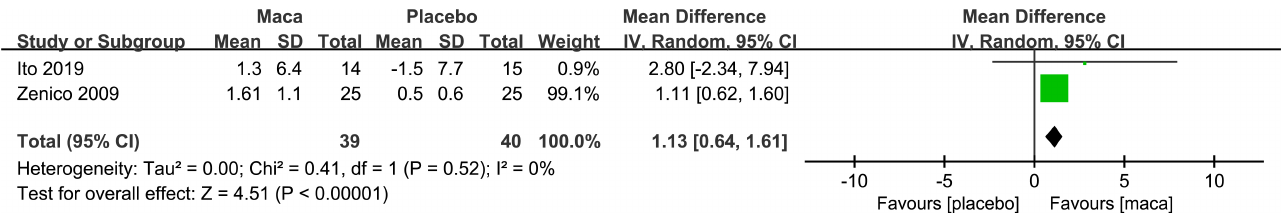
FIGURE 2. Risk of bias. (A) Risk-of-bias graph and (B) risk-of-bias summary.